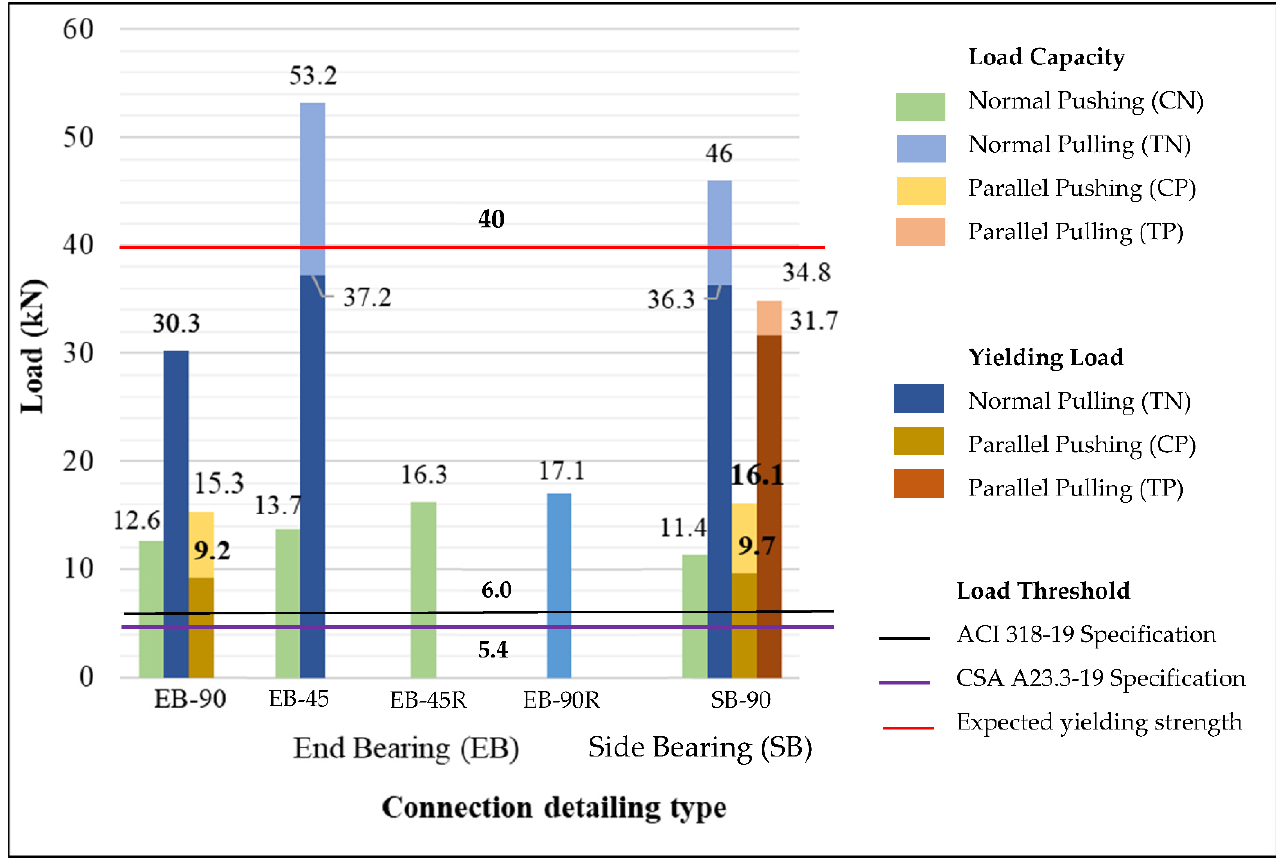
Figure 9. Connection capacity. In contrast, end-bearing connections tested under compression exhibited less than half the capacity of their counterparts under tension forces due to bar bending or buckling, without developing the yielding strength of the bar. Specimens EB-CN-90 and EB-CN-45 attained a capacity of 12.6 kN and 16.3 kN, respectively, at a displacement of 3.9-mm, which indicates that the bar was at the early stages of its linear-elastic behavior when bending started. These results also demonstrated that decreasing the bend angle from 90 to 45-degree resulted in a 29% increase in the load capacity. However, minimizing the unrestrained length of the bar, in end-bearing connections with either 90 or 45-degree bar bends, did not significantly increase the connection capacity. Specimens EB-CN-90R and EB-CN-45R reached a capacity of 13.7 and 17.1 kN, respectively. This represents an 8.0 and 5.0% increase in the load capacity compared to their counterparts with the unrestrained length of 70 mm,